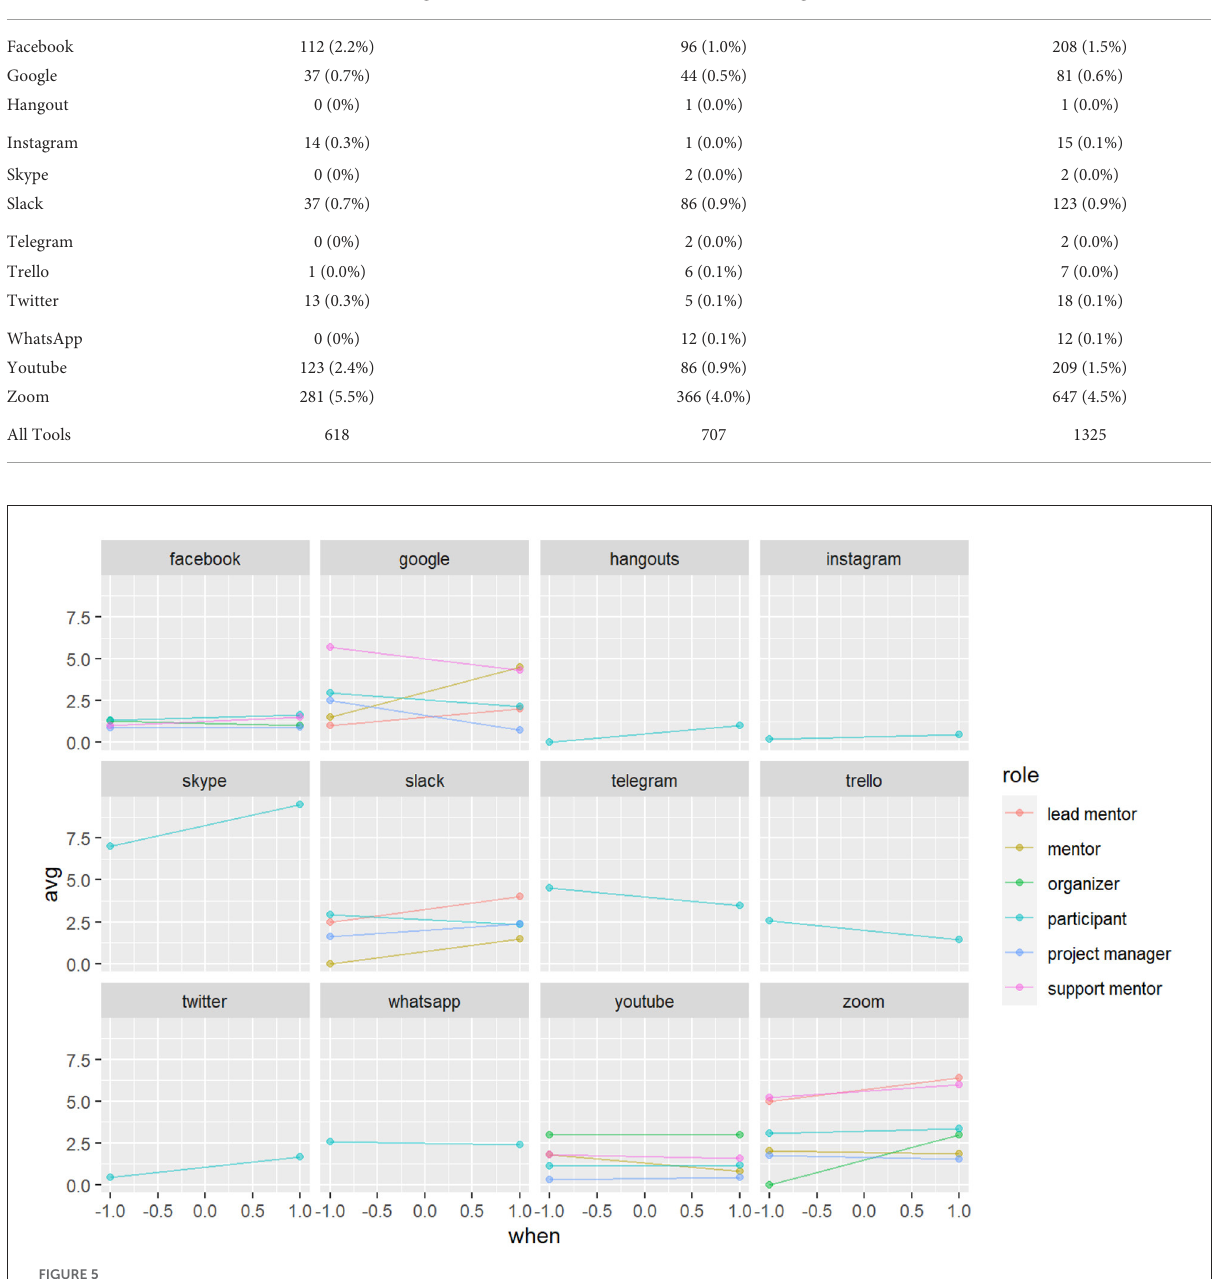
of messages before ( M = 1.31, SD = 2.85) the mentions